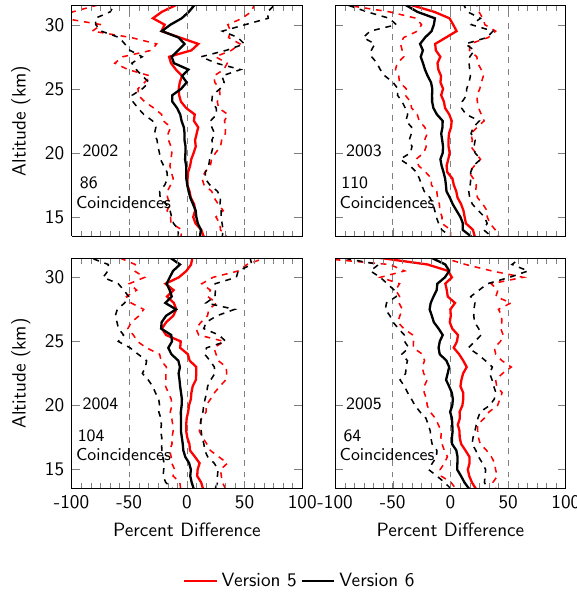
Fig. 13. Comparison of coincident SAGE III 755nm aerosol extinction and OSIRIS 750nm aerosol extinction. Each panel shows one year of coincident comparisons with the number of coincident profiles indicated in the respective panel. Mean percentage differences are shown as solid lines with standard deviation shown as dashed. Version 5 retrievals are shown in red with Version 6 shown in black.